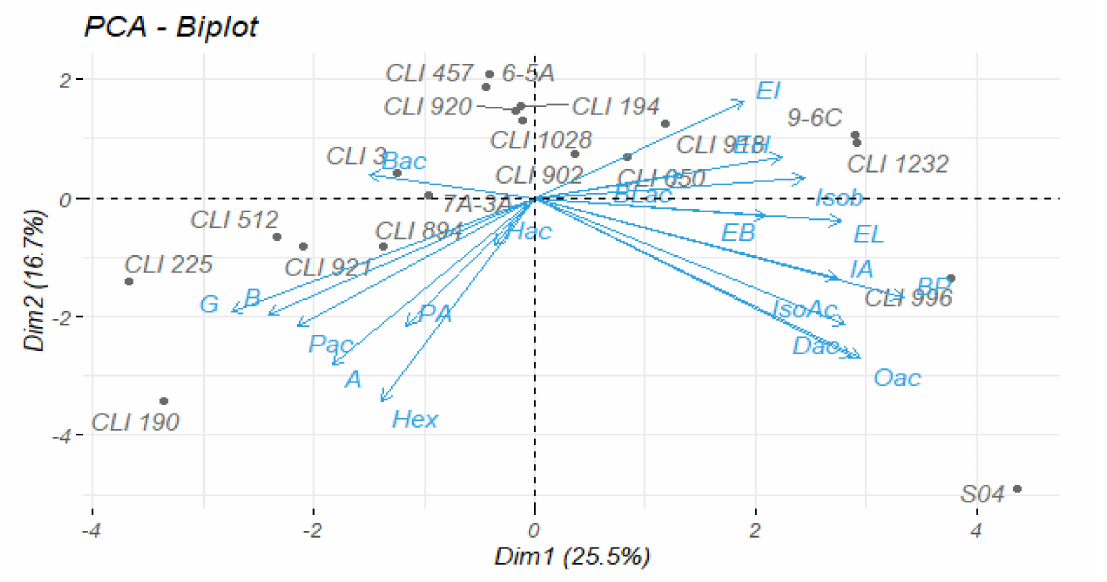
Figure 2. Projection of the beers on the axes formed by the principal components 1 and 2. Each object is the average of the three corresponding experimental beers. Isob, isobutanol; IA, isoamyl alcohol; Hex, 1-hexanol; BP, β -phenylethanol; EB, ethyl butyrate; EI, ethyl isovalerate; IsoAc, isoamyl acetate; EH, ethyl hexanoate; EL, ethyl lactate; PA, 2-phenethyl acetate; Bac, butyric acid; Hac, hexanoic acid; Oac, octanoic acid; Dac, decanoic acid; A, acetoin; B, benzaldehyde; Pac, phenyl acetaldehyde; BLac, γ -butyrolactone; G, guaiacol.